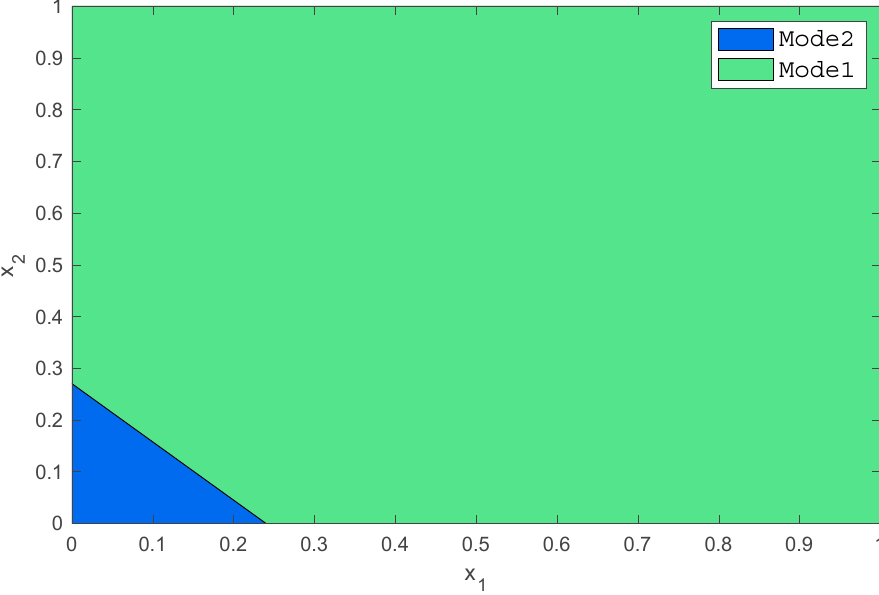
Figure 2. Boundary condition of operating space obtained with proposed method. x 1 , x 2 are the state variables of the multiple model.